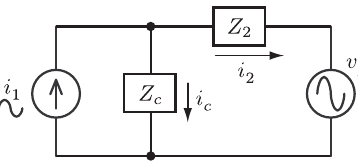
Figure 7. Closed-loop scheme with CCF in the { α , β }